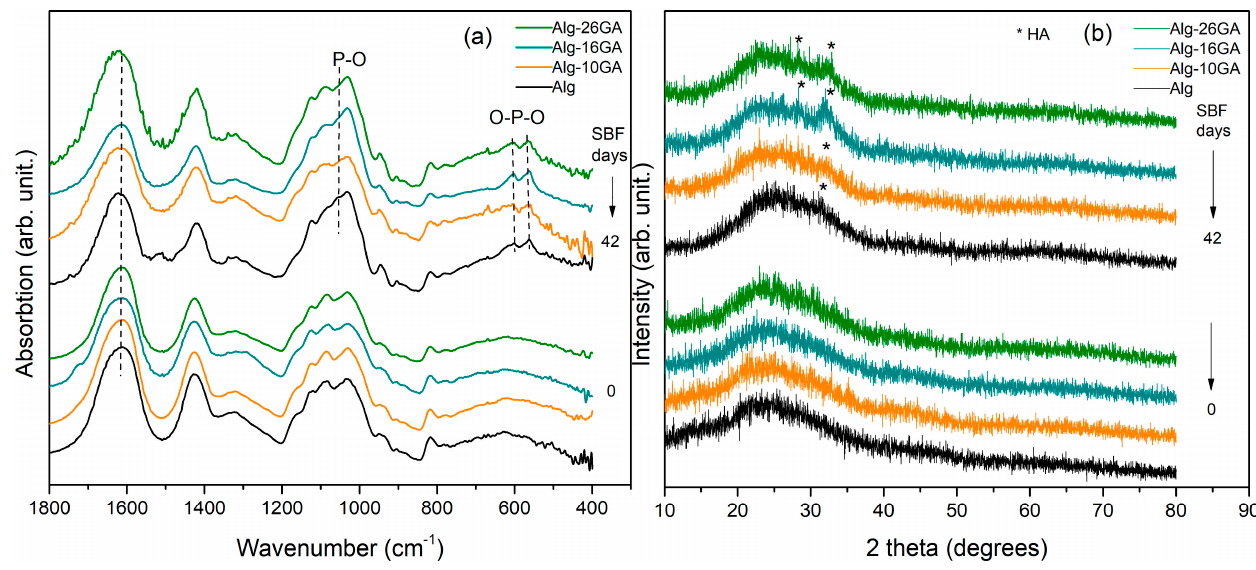
Figure 6. FT-IR spectra ( a ) and XRD patterns ( b ) of Alg-xGA (x = 0, 10, 16, and 26 wt.%) composites, before and after immersion in simulated body fl uid up to 42 days.